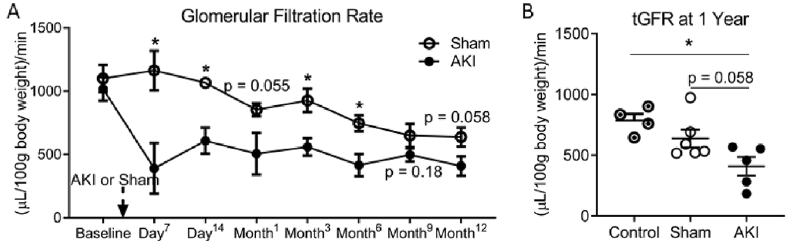
Figure 1. Measured transcutaneous glomerular filtration rate (tGFR) in females after AKI. Female mice underwent 34 min of bilateral renal ischemia or sham. ( A ) AKI resulted in a persistent decrease in tGFR compared to sham throughout the study. ( B ) One year after AKI, tGFR was reduced compared to healthy age- matched controls. (n = 5–7) *Signifies P < 0.05.